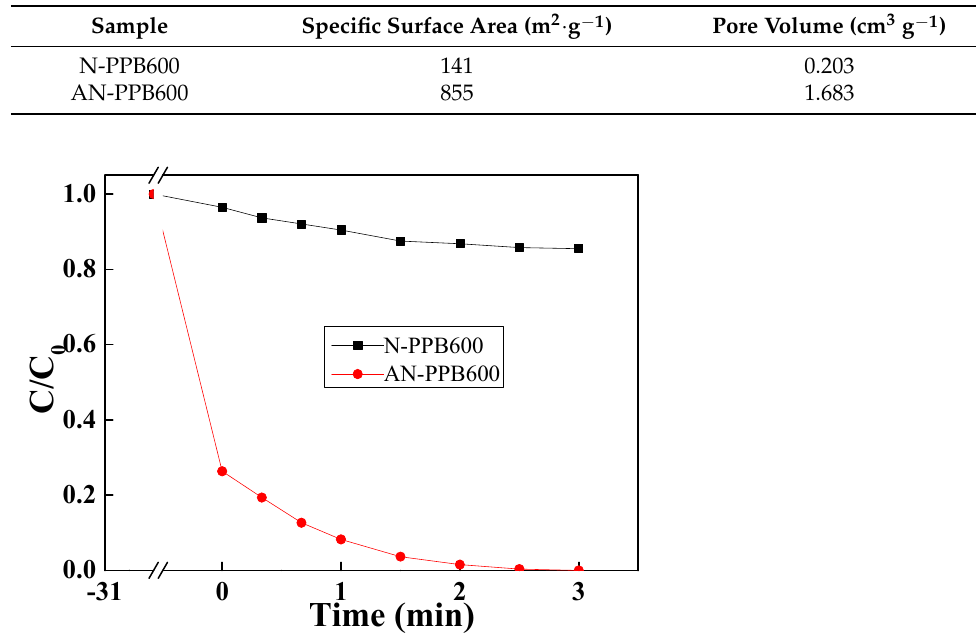
Figure 9. BPA degradation in N-PPB600/PMS and AN-PPB600/PMS systems ([catalyst] 0 = 0.5 g/L, [BPA] 0 = 0.02 mM, [PMS] 0 = 1.5 mM).